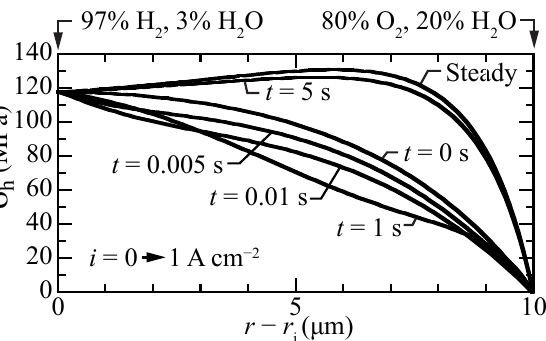
Figure 9. Transient hydrostatic stress profiles within the membrane, beginning at open circuit and suddenly imposing a fuel-cell current density of i = 1 A cm − 2 .